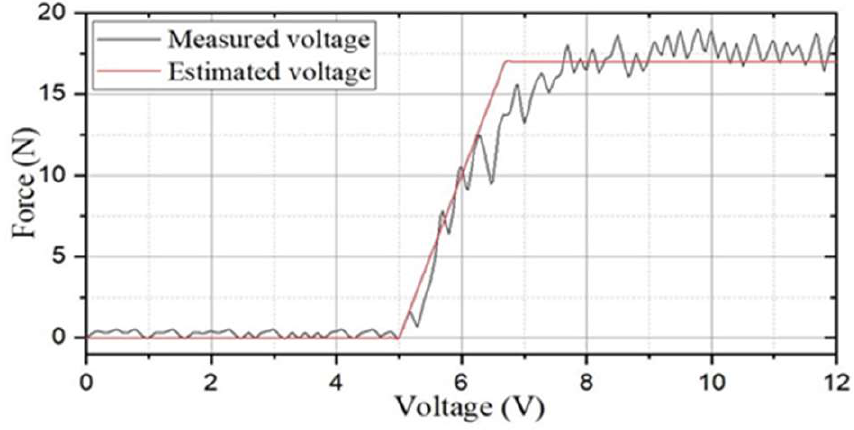
Figure 8. The propulsive force of the different power.